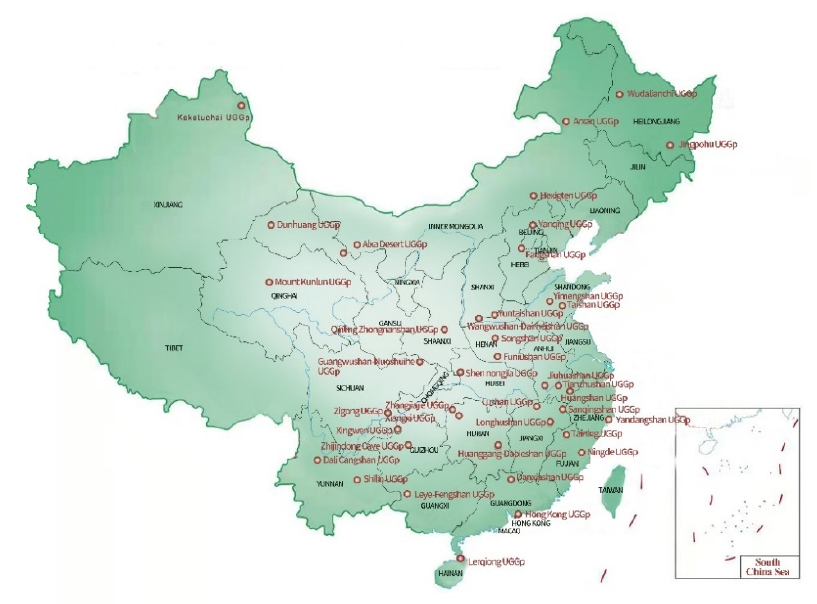
Figure 7. Map of UNESCO Global Geoparks in China.